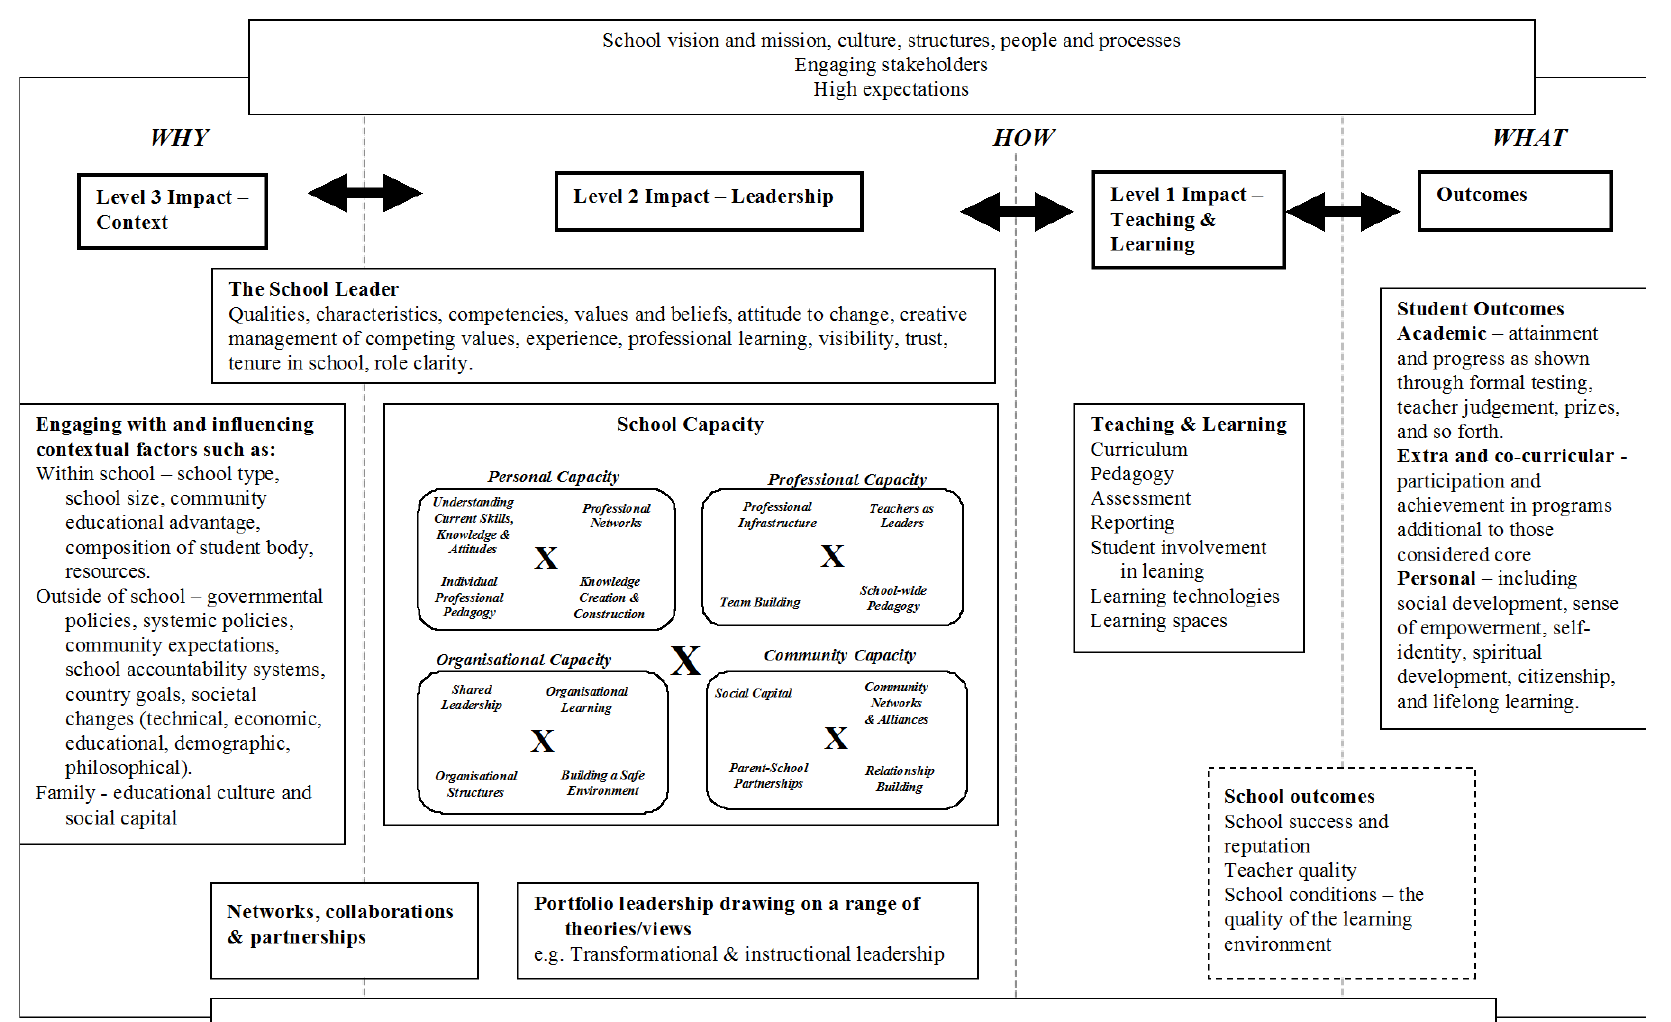
Figure 1. An International Successful School Principalship Project (ISSPP) model of successful school